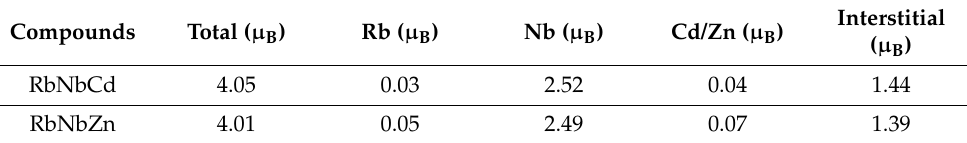
Table 3. The total and local magnetic moments of both compounds.